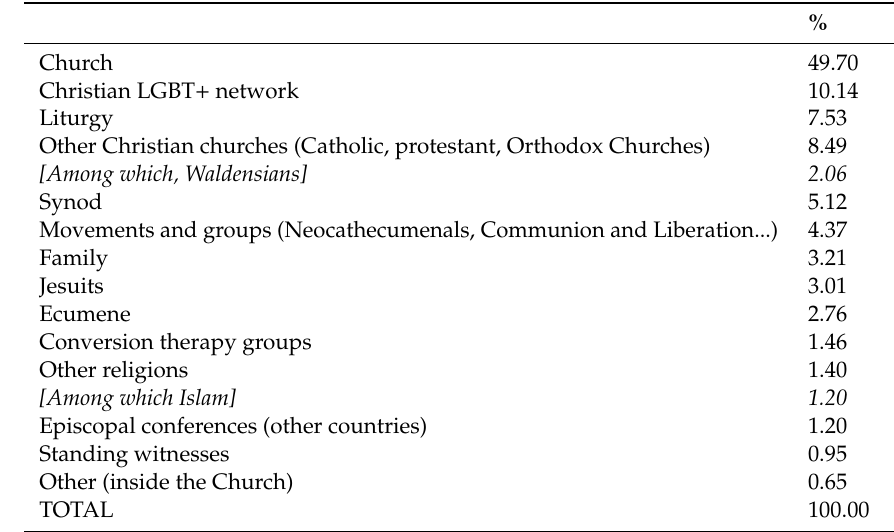
Table 2. Religious